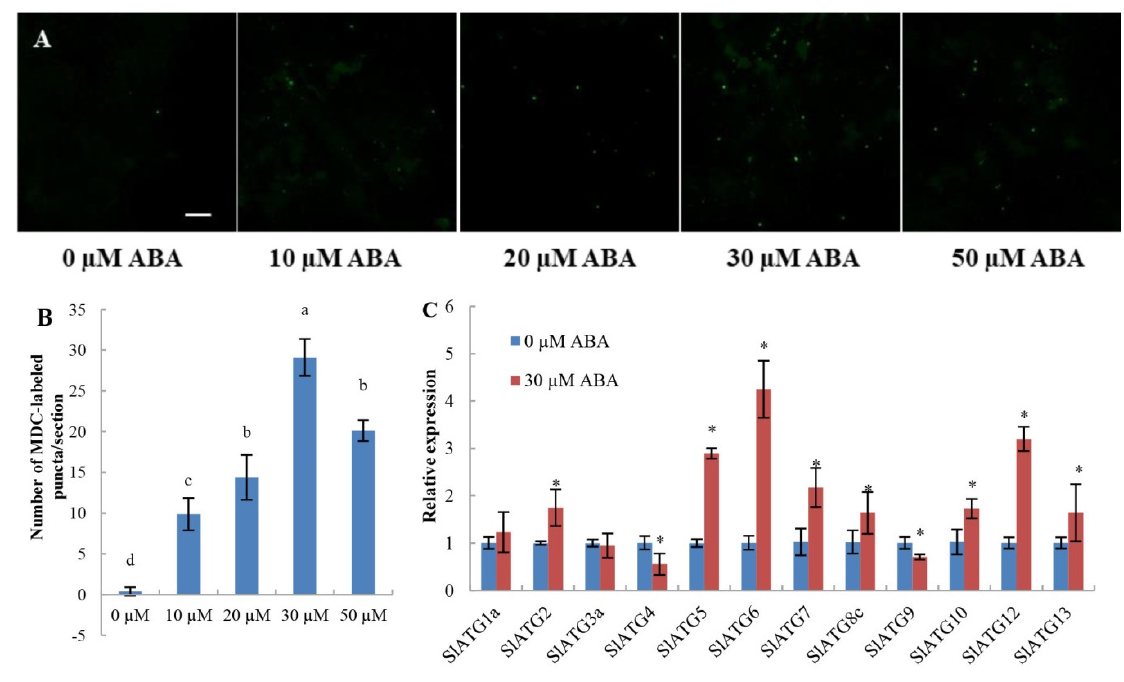
Figure 6. Effects of ABA on the induction of autophagy in tomato leaves. ( A ) MDC-stained autophagosomes in the leaves of WT tomatoes. Six-week-old plants were treated with 0, 10, 20, 30 or 50 µ M ABA, and the leaves were stained with MDC and visualized at 12 h by confocal microscopy. Autophagosomes by MDC staining are shown as green signals. Bars: 50 µ m. ( B ) The number of autophagosomes by MDC staining per image in ( A ) was quantified to calculate the autophagy activity. Data are expressed as the mean ± SD of seven biological replicates. Different lowercase letters indicate significant differences according to Duncan’s multiple range test ( p < 0.05). ( C ) Relative expression of SlATGs in WT tomato leaves after 0 µ M and 30 µ M ABA treatment. Data are expressed as the mean ± SD of biological triplicates. An asterisk (*) on top of the error bar indicates a significant difference between different treatments at p < 0.05.